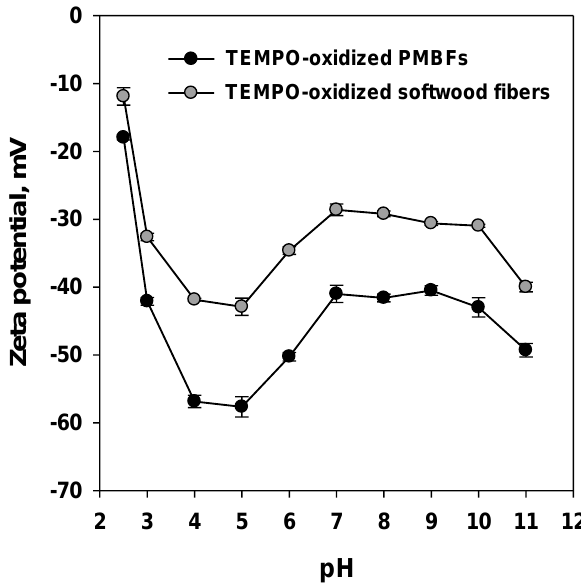
Figure 2. Zeta potential of TEMPO-oxidized PMBFs and softwood fibers at different pH.